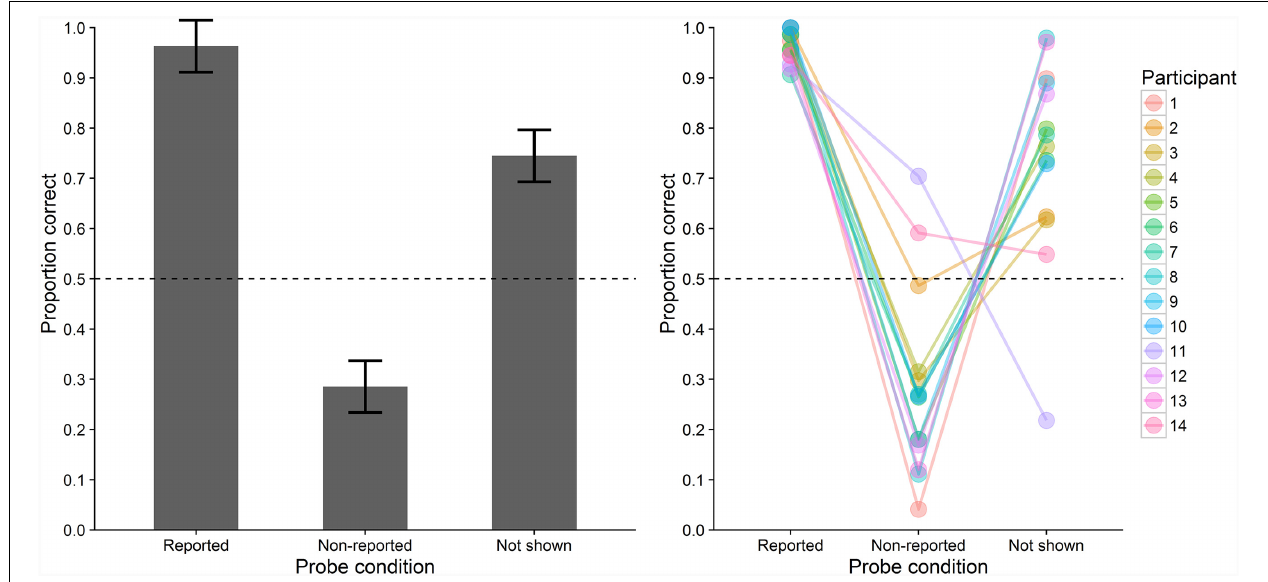
FIGURE 3 | Mean probe recognition performance (proportions of correct responses to probe letters) in Experiment 1 across all participants (bars, left) and for individual participants (colored points, right) in the three conditions. Error-bars indicate ± 1 SE for within-subjects designs (Loftus and Masson, 1994). Chance level is indicated by the dashed